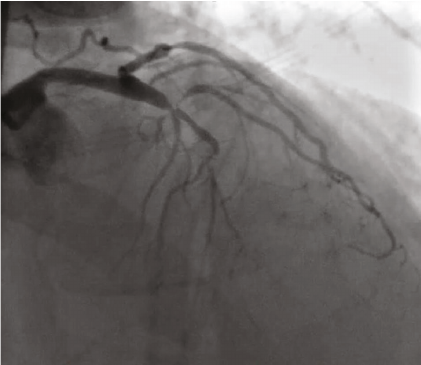
Figure 1: Left coronary angiography demonstrating severe stenosis of the left circum fl ex artery and CTO of the